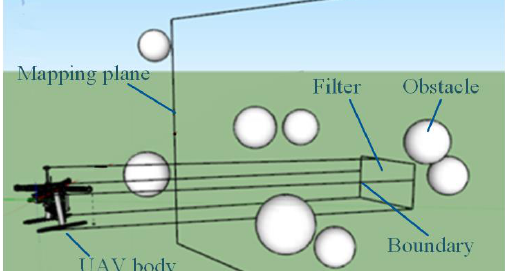
Figure 9. Graphical explanation of the CACSD distinguishing the safety zone.